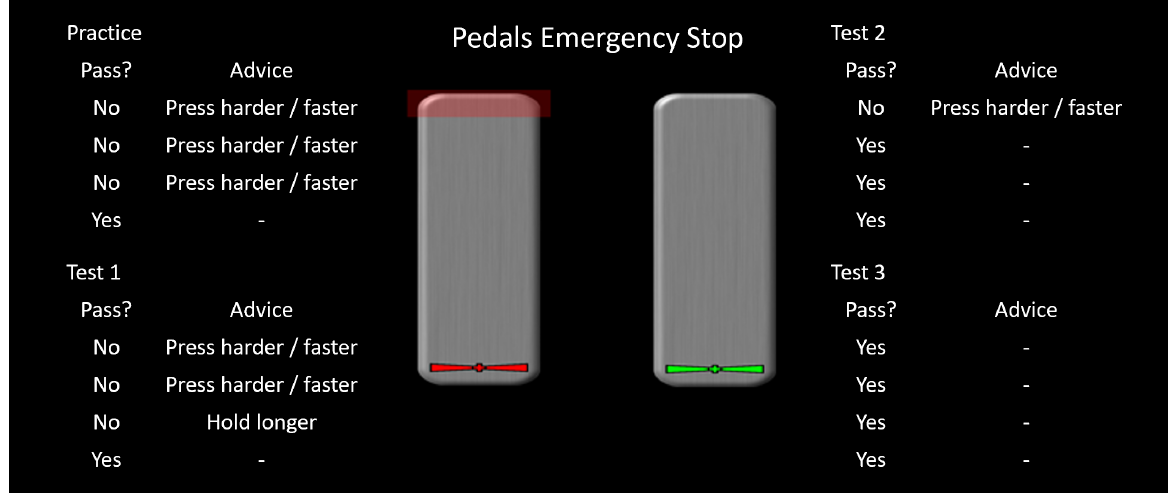
Figure 10. Example of the proposed Pedals Emergency Stop© combined task and results layout.